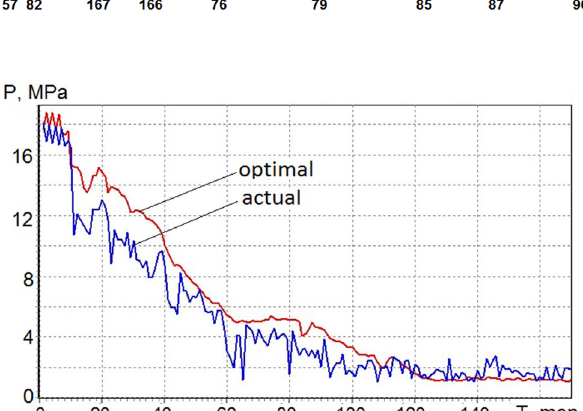
Fig. 7 Minimum pressure in the Kotelevske gas reservoir for optimal and «actual»